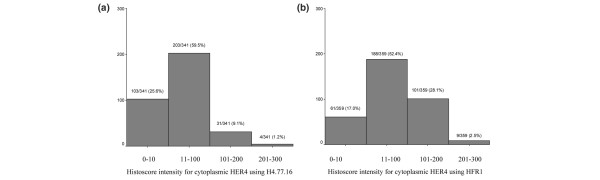
Frequency histograms for cytoplasmic staining intensity using (a) H4.77.16 and (b) HFR1.